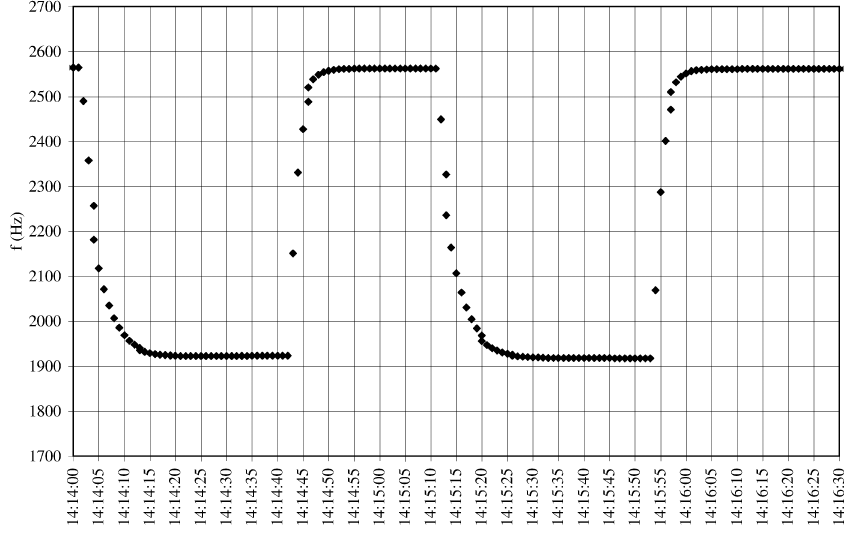
FIG. 7. Transient characteristics of the wire oscillation frequency at switching on/off current I (cid:1) 215 mA through the wire. Both ends of the wire are